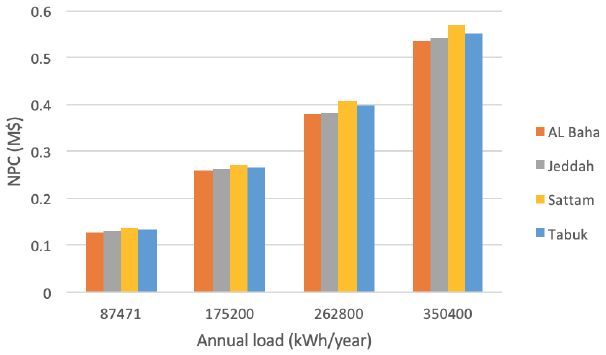
Figure 14: Load demand changing for selected